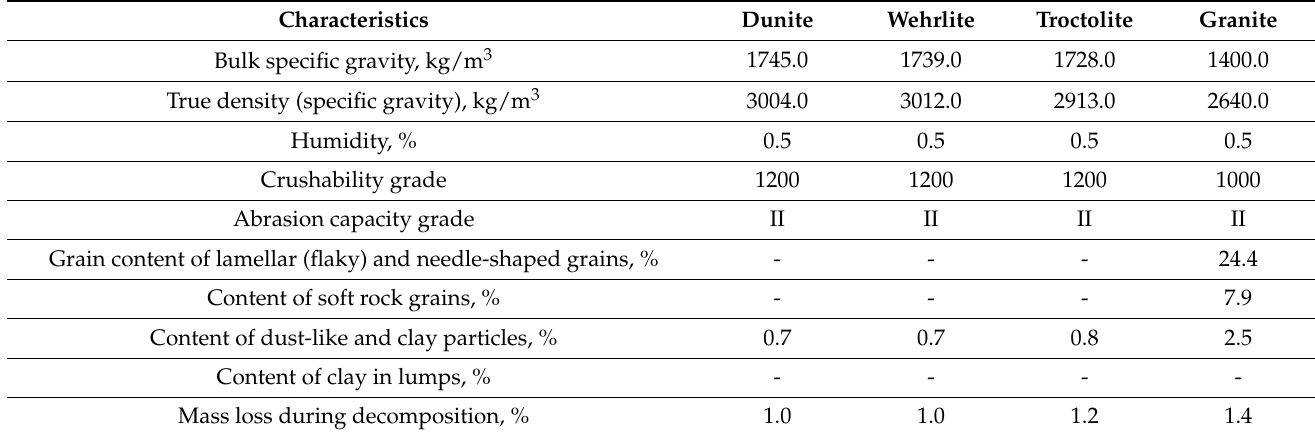
Table 2. Physical and mechanical characteristics of the crushed stone.